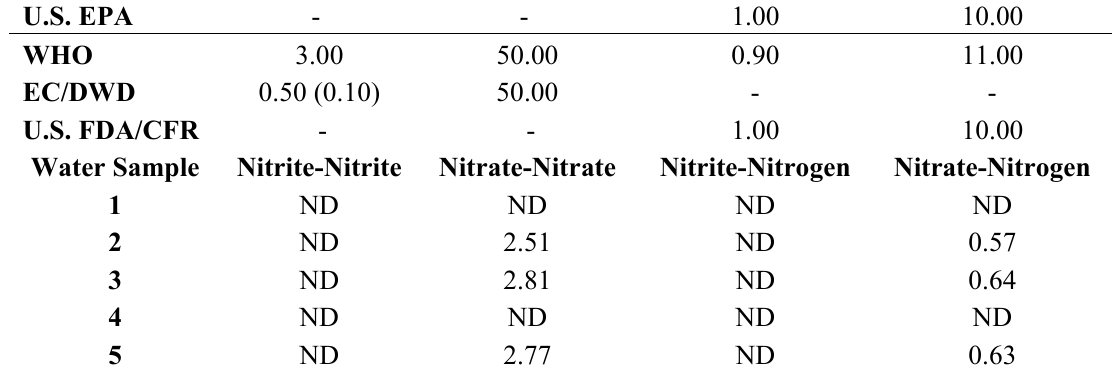
Table 2. Nitrite and nitrate (mg·L − 1 ) levels measured in the bottled water samples, compared to the U.S. EPA [19], WHO [16], EC/DWD [22], and U.S. FDA/CFR [20,21] standard